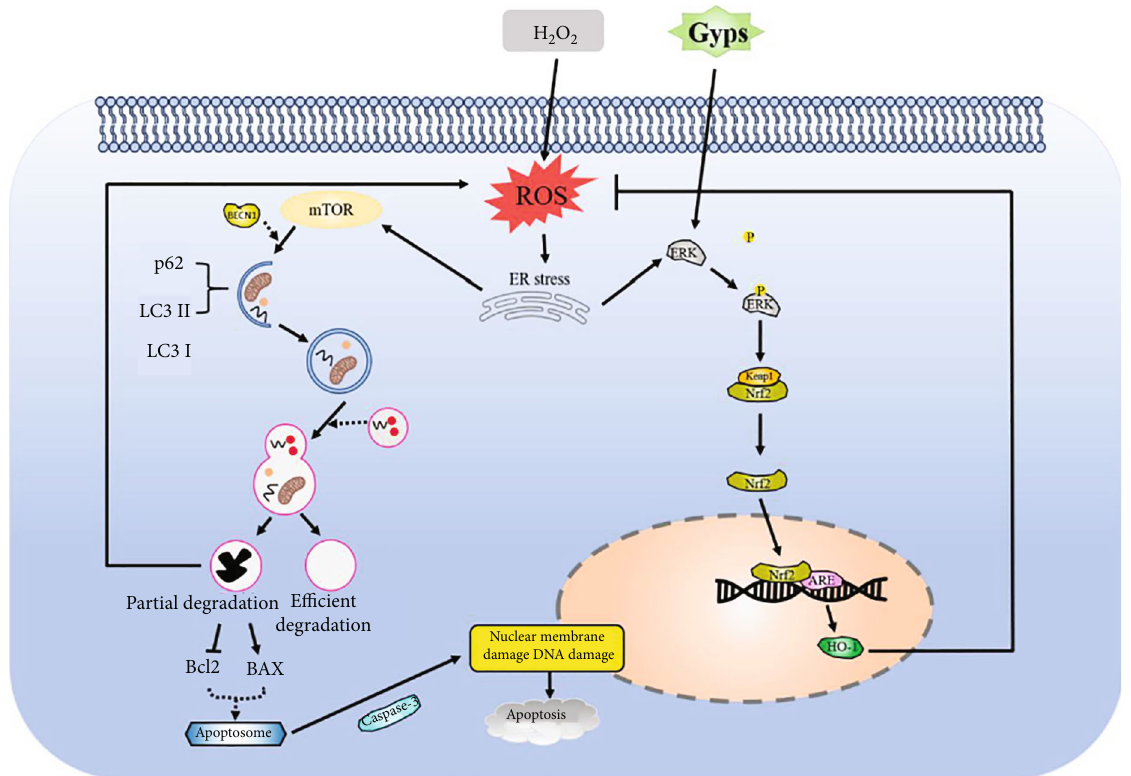
Figure 15: Schematic diagram of changes in orbital fi broblasts under the intervention of oxidative stress and gypenosides. Under the condition of oxidative stress, the increase of endogenous ROS leads to the occurrence of endoplasmic reticulum stress. On the one hand, endoplasmic reticulum stress induces the occurrence of autophagy. If the oxidative stress damage is serious, autophagy cannot fully digest the damaged organelles. It will lead to increased ROS production and promote the start of apoptosis-related processes leading to apoptosis. On the other hand, endoplasmic reticulum stress can promote ERK phosphorylation, allowing Nrf2 to interact with its inhibitor under oxidative stress, causing Nrf2 to accumulate in the cytoplasm, and Nrf2 translocated to the nucleus and combined with antioxidant response elements. Gypenosides as an antioxidant can enhance the role of endogenous Nrf2 pathway activator. Under oxidative stress, gypenosides can promote ERK phosphorylation and accelerate the dissociation of Nrf2 from Keap1, resulting in more Nrf2 translocation to the nucleus. NRF2 binds through antioxidant response elements and regulates the expression of its downstream target gene (HO-1), to prevent oxidative stress and